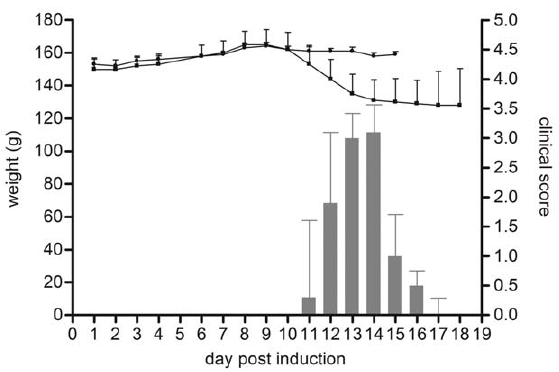
Figure 1. Clinical scores and weight changes of EAE and control animals. EAE was induced by injection of MBP in CFA (bars and squares). Control animals were CFA injected (dots). The controls showed no clinical symptoms. Each value represents the mean 6 standard deviation of n animals: control day1-15, n=3; EAE day1–9, n=9; day10–14, n=6 and day15–18,